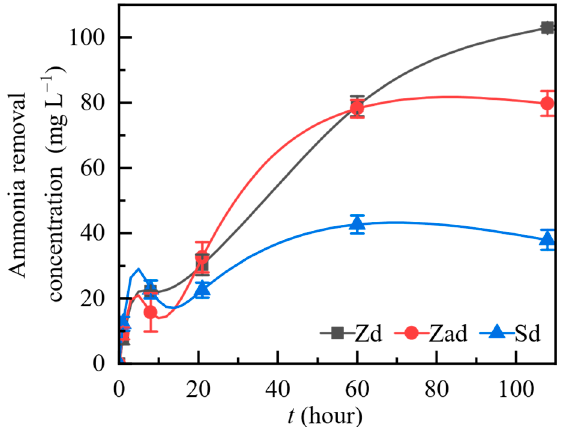
Figure 6. Nitrogen adsorption kinetics with three zeolite treatment groups. Black squares indicate heat-dried zeolite (Zd); red circles indicate air-dried zeolite (Zad); blue triangles indicate heat-dried soil without zeolite (Sd).